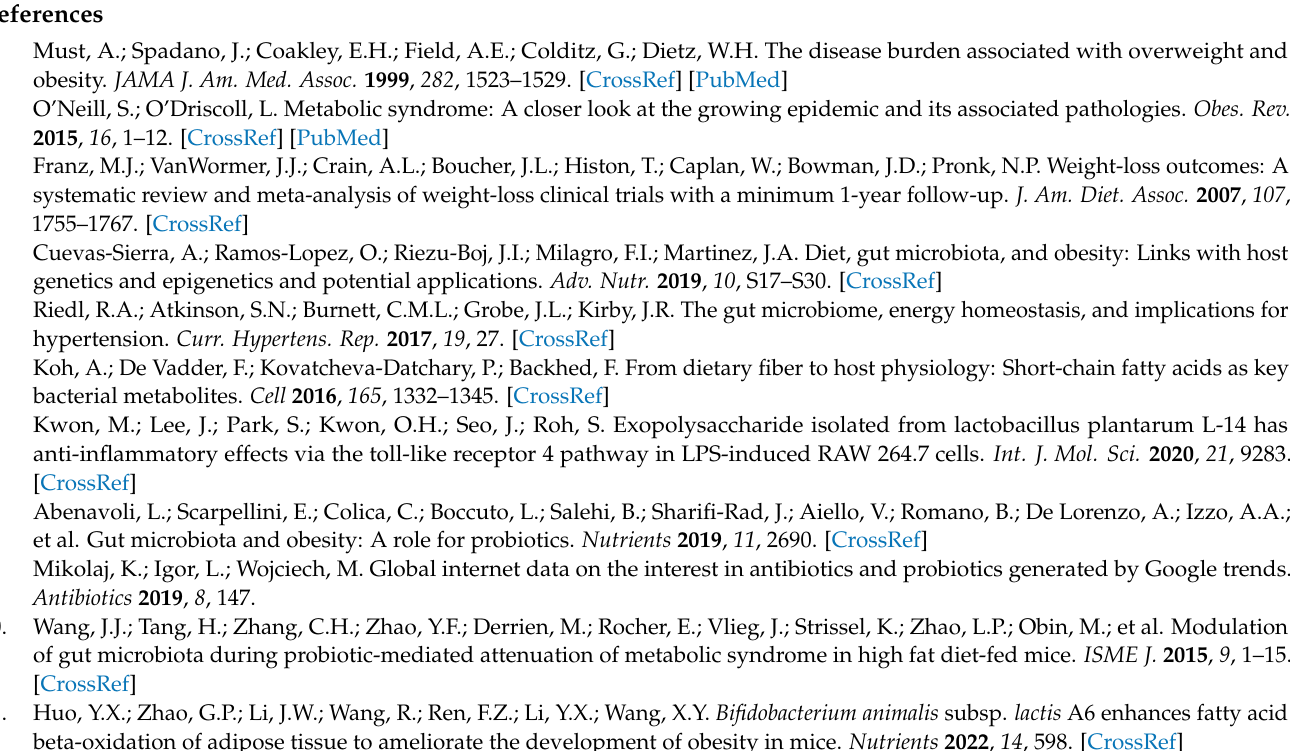
ing MN-Gup; MN-Gup FM + GOS, fermented milk containing MN-Gup and galacto-oligosaccharides (GOS); MN-Gup FM + XOS, fermented milk containing MN-Gup and xylo-oligosaccharides (XOS); Figure S4: Effects of fermented milk containing MN-Gup or MN-Gup-based synbiotics on the pro- portion of primary and secondary bile acids (BAs) in colonic feces. ND, normal diet; HFD, fed high-fat diet; MN-Gup FM, fermented milk containing MN-Gup; MN-Gup FM + GOS, fermented milk containing MN-Gup and galacto-oligosaccharides (GOS); MN-Gup FM + XOS, fermented milk containing MN-Gup and xylo-oligosaccharides (XOS) ( n = 4 in ND group, and n = 5 in the rest groups); Table S1: The tested bile acids and their abbreviation; Table S2: OTU assignments in the correlation